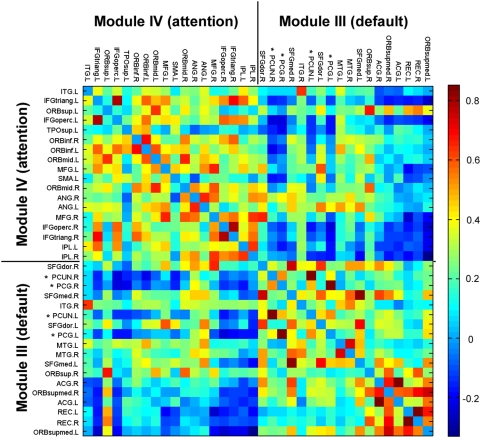
The anti-correlation map between module III and module IV.We show the inter-regional correlations between module III and module IV. The two key regions in the ‘default’ subnetwork (module III), the posterior cingulate cortex and precuneus (asterisk signs), exhibit dramatically negative correlations with most of brain regions in the attention subnetwork (module IV). The color bar indicates the correlation coefficients. Note that the correlation matrix is extracted from Figure 1A.